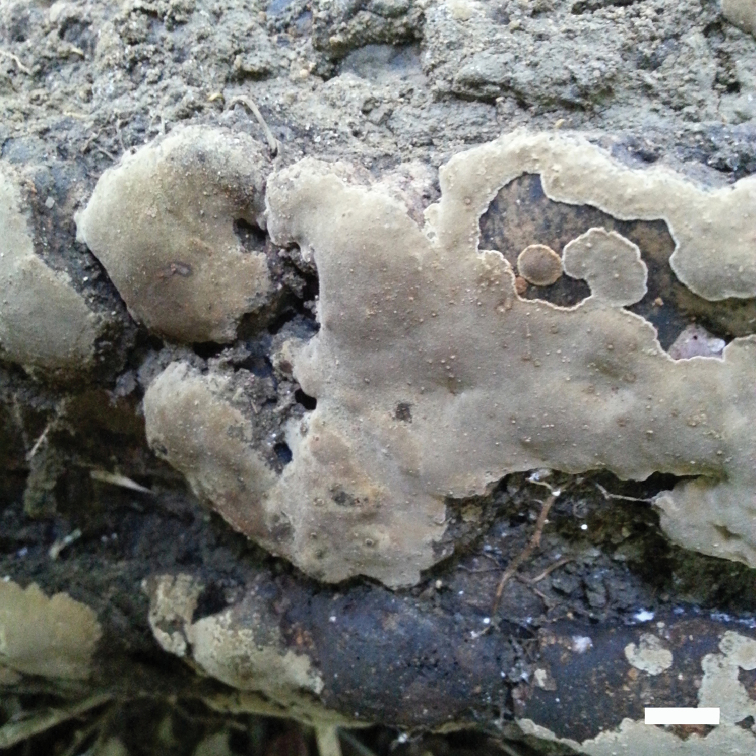
A basidiocarp of Fomitiporella
austroasiana. Scale bar: 1 cm.